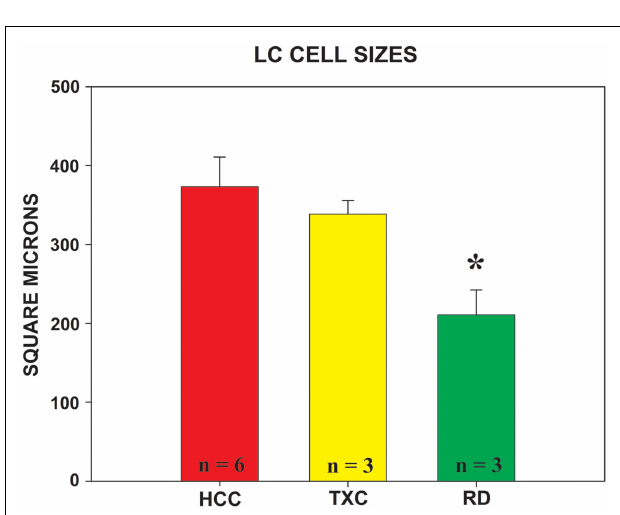
FIGURE 5 | Mean area ofTH-ir cells measured in the locus coeruleus in each group. The nucleator probe, utilized in conjunction with the fractionator, provides the estimated value of cell size. Group designations are as given in Figure 4 . HCC = red bar;TXC = yellow bar; RD = green bar; ∗= different from HCC, p = 0.039 (Bonferroni post hoc corrected t -test).